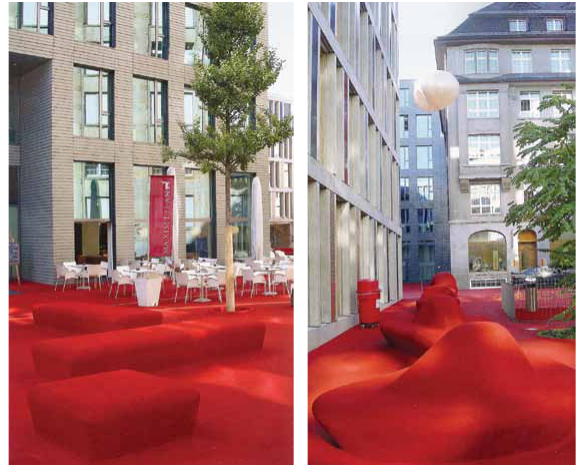
Fig. 4. recreation square “The Greatest room of Switzerland”, the town of St Galen in Switzerland (architect C.